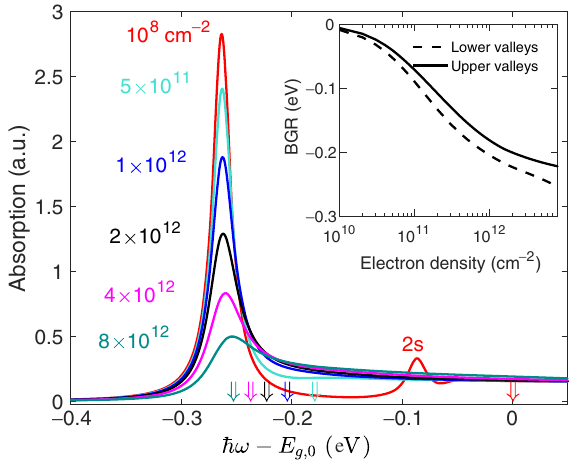
FIG. 6. Characteristic effect of long-wavelength plasmons on the absorption spectrum of neutral excitons in ML-TMDs. Increasing the background charge density leads to a decay of the exciton peak. The BGR is indicated by the arrows on the x axis, showing the redshift for the onset of optical transitions in the continuum (noninteracting electron-hole pairs). Inset: BGR of the upper and lower valleys as a function of electron density in the lower valleys. The signatures of dynamical screening and BGR are qualitatively the same when choosing other parameters of effective masses and dielectric constants (Appendix A